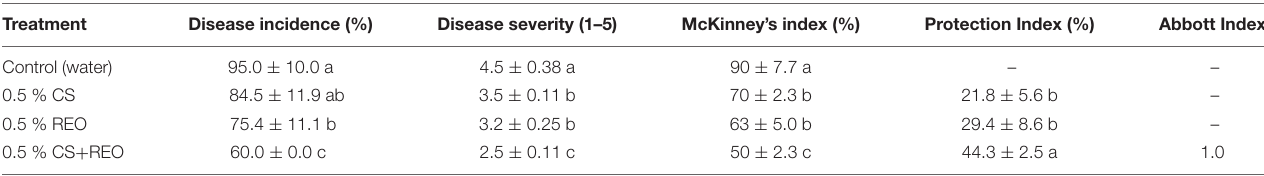
TABLE 2 | Effects of the chitosan (CS), Ruta graveolens essential oil (REO), and CS-REO treatments on the incidence and severity of the papaya fruit decay after 9 days of storage at 25 ± 1 ◦ C.